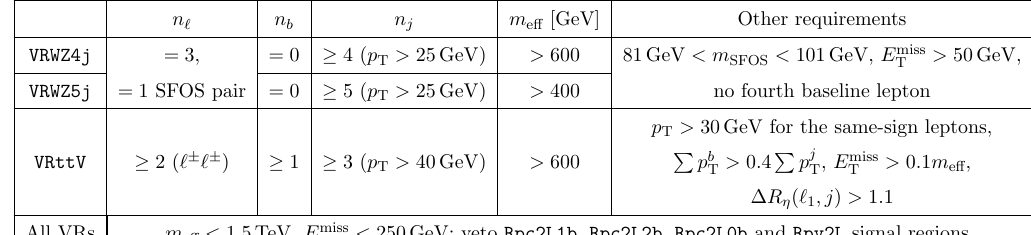
Table 3. Event selection de(cid:12)ning the three validation regions enriched in WZ +jets and t (cid:22) tV SM processes, based on the variables de(cid:12)ned in section